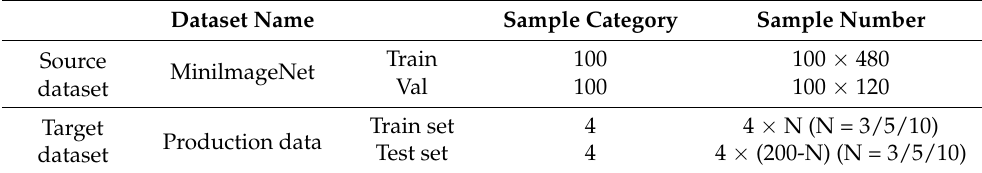
Table 5. Production line bearing dataset fault classification.